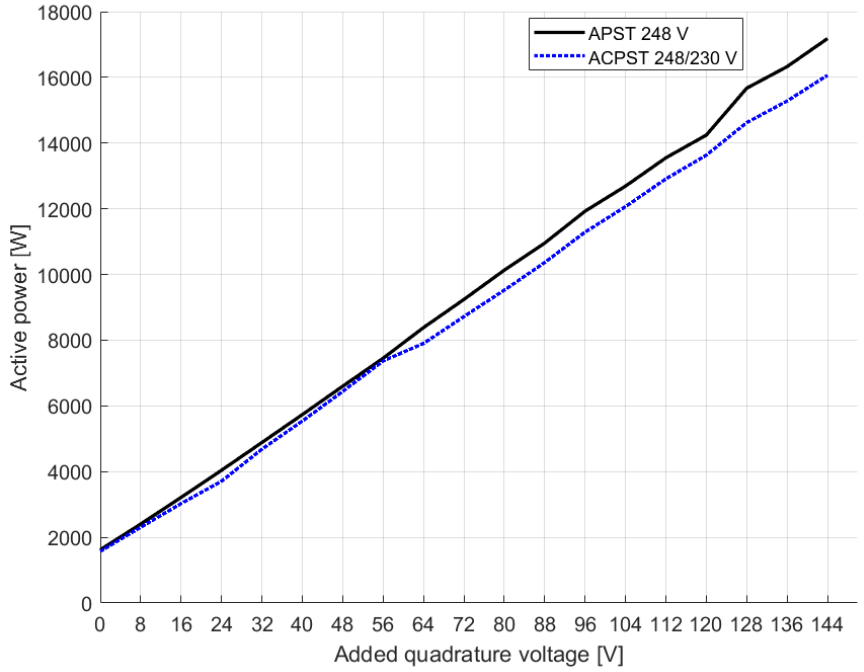
Figure 14. The active power transfer through the 22 sections line with APST (black) and ACPST (blue dotted). Table 5. The output voltages for APST and ACPST comparison.